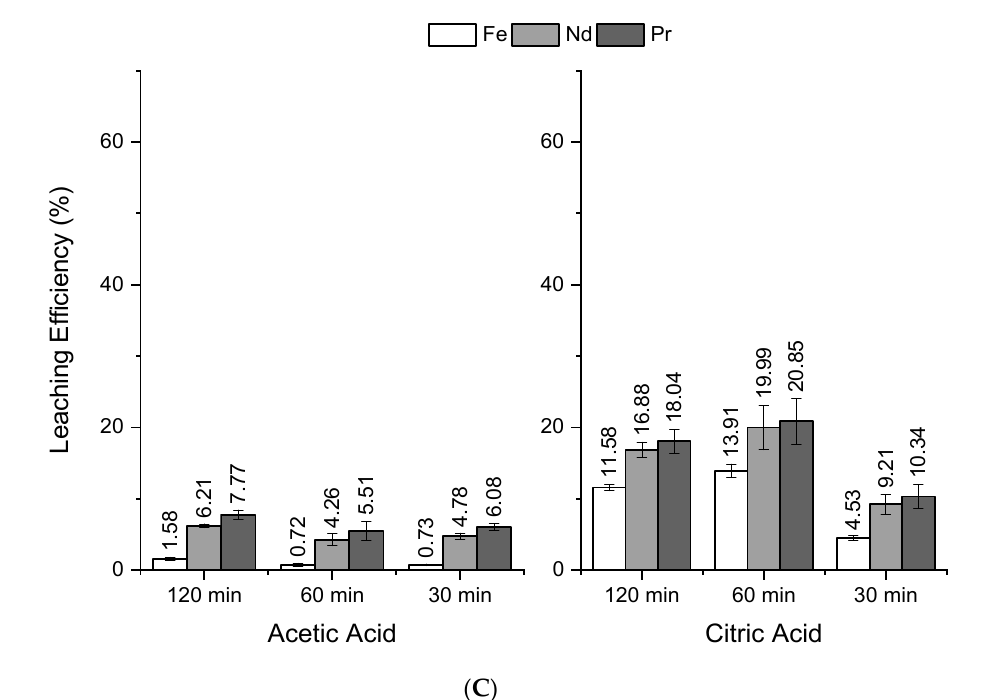
Figure 6. Comparison of the leaching efficiency of NdFeB magnets in acetic and citric acids, concen- tration 1 M, ratio s/l ( A ) 1/100; ( B ) 1/50 and ( C ) 1/10.